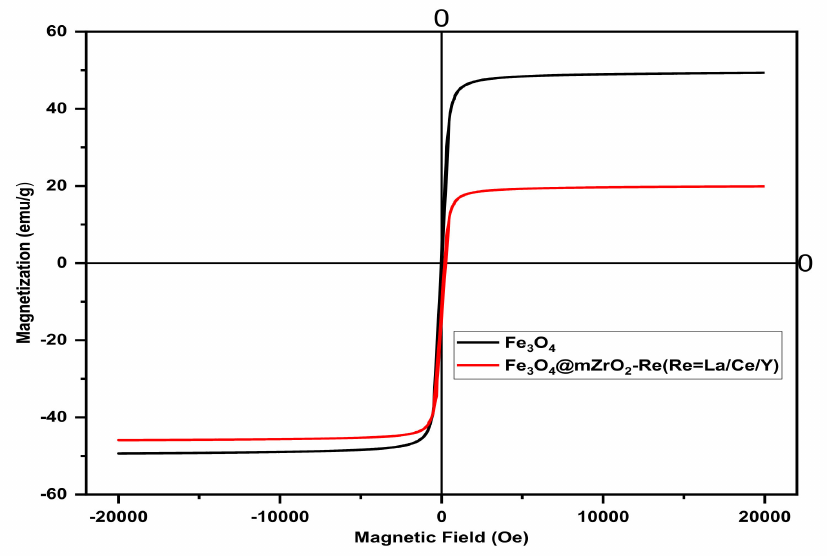
Figure 5. VSM Spectra of Fe 3 O 4 and Fe 3 O 4 @mZrO 2 -Re (Re = Y/La/Ce).